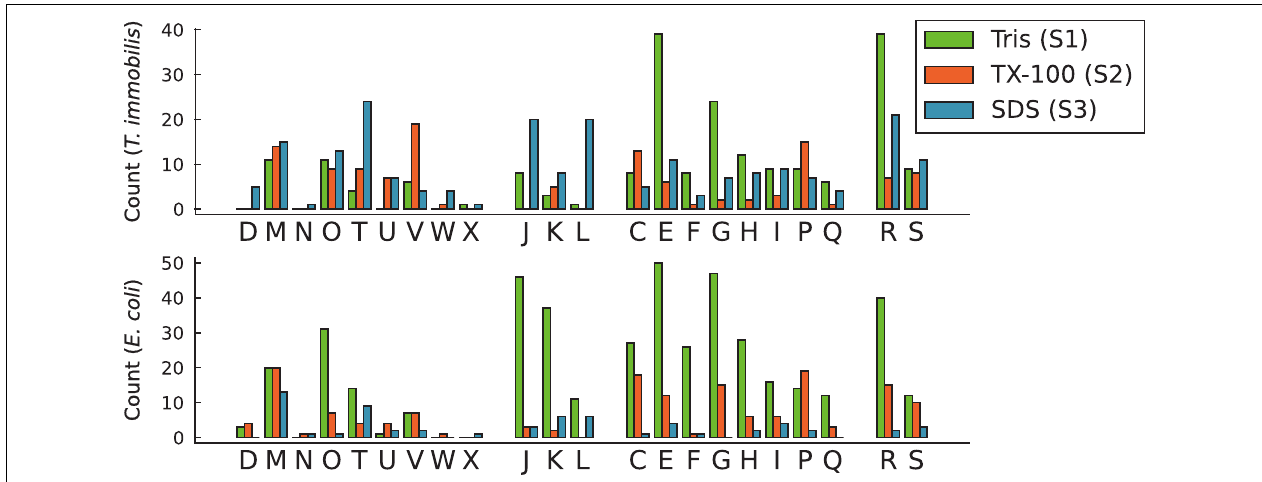
FIGURE 10 | Functional analysis of T. immobilis and E. coli subcellular proteomes based on COGs. The number of fraction-specific proteins is shown as a function of the COG category for the proteomes of T. immobilis and E. coli . One-letter abbreviations and full names of COG categories: Amino acid transport and metabolism (E), carbohydrate transport and metabolism (G), cell cycle control, cell division, chromosome partitioning (D), cell motility (N), cell wall/membrane/envelope biogenesis (M), chromatin structure and dynamics (B), coenzyme transport and metabolism (H), defense mechanisms (V), energy production and conversion (C), extracellular structures (W), function unknown (S), general function prediction only (R), inorganic ion transport and metabolism (P), intracellular trafficking, secretion, and vesicular transport (U), lipid transport and metabolism (I), mobilome: prophages, transposons (X), nucleotide transport and metabolism (F), posttranslational modification, protein turnover, chaperones (O), RNA processing and modification (A), replication, recombination and repair (L), secondary metabolites biosynthesis, transport and catabolism (Q), signal transduction mechanisms (T), transcription (K), translation, ribosomal structure, and biogenesis (J).